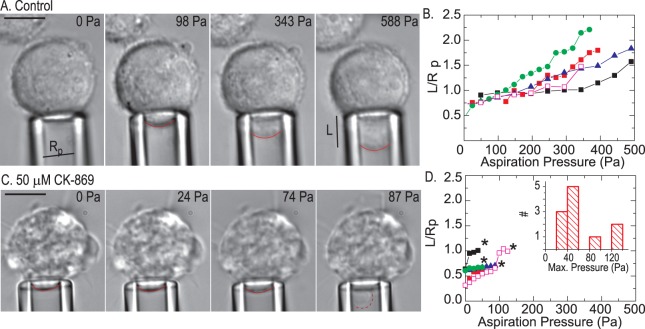
Arp 2/3 inhibition induces bleb formation at low external pressures.(A) Phase contrast images of wildtype cells in a micro-pipette aspiration experiment as the aspiration pressure is increased from 0 Pa to 588 Pa. Aspiration pressure indicated in upper right. Scale bar is 3 µm. Cell contour within the micropipette indicated by red line. The pipette radius R and the length L of cell extended into the pipette are indicated in the images. (B) L/Rp as a function of aspiration pressure for wildtype cells; each data series reflects data (C) Phase contrast images of cells treated with the Arp inhibitor CK-869 in an aspiration experiment with cell contour within the pipette indicated. In the highest pressure (87 Pa), a bleb abruptly forms within the pipette, indicated by dashed red line. Scale bar is 3 µm. (D) L/Rp as a function of aspiration pressure for Arp inhibited cells. Note that bleb formation occurs at low pressures (stars), with a mean of 45 Pa. Inset, histogram of pressures at which blebs form.